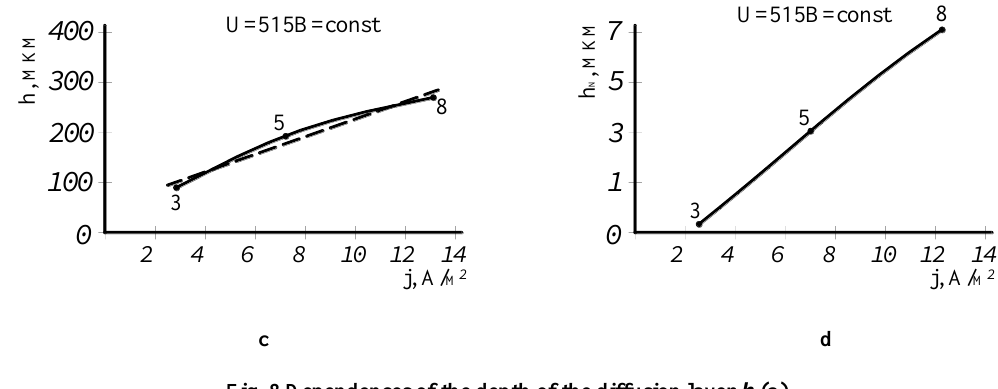
Fig. 8 Dependences of the depth of the diffusion layer h (a) and the nitride layer hN (b) on the voltage at j = 7.2 A / m 2 = const; also c and d on the current density j at U = 515B =